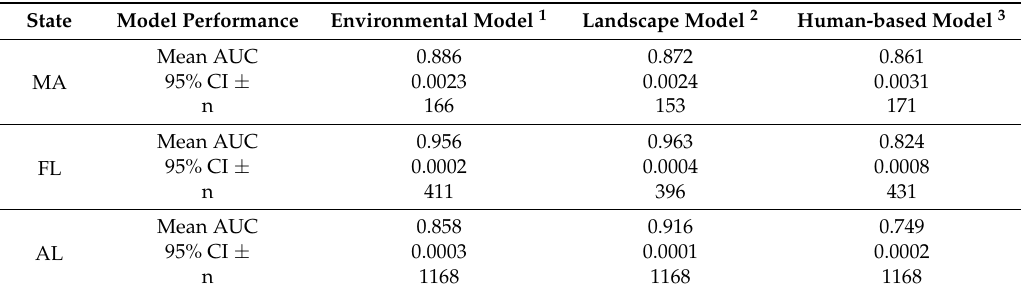
Table 7. Evaluation of environmental layer classes for their influence on raccoon risk model results for pine-dominated landscapes of Massachusetts, Florida, and Alabama during 5 January 2012–26 June 2014: 5 bootstrap replicated runs. All AUC values are